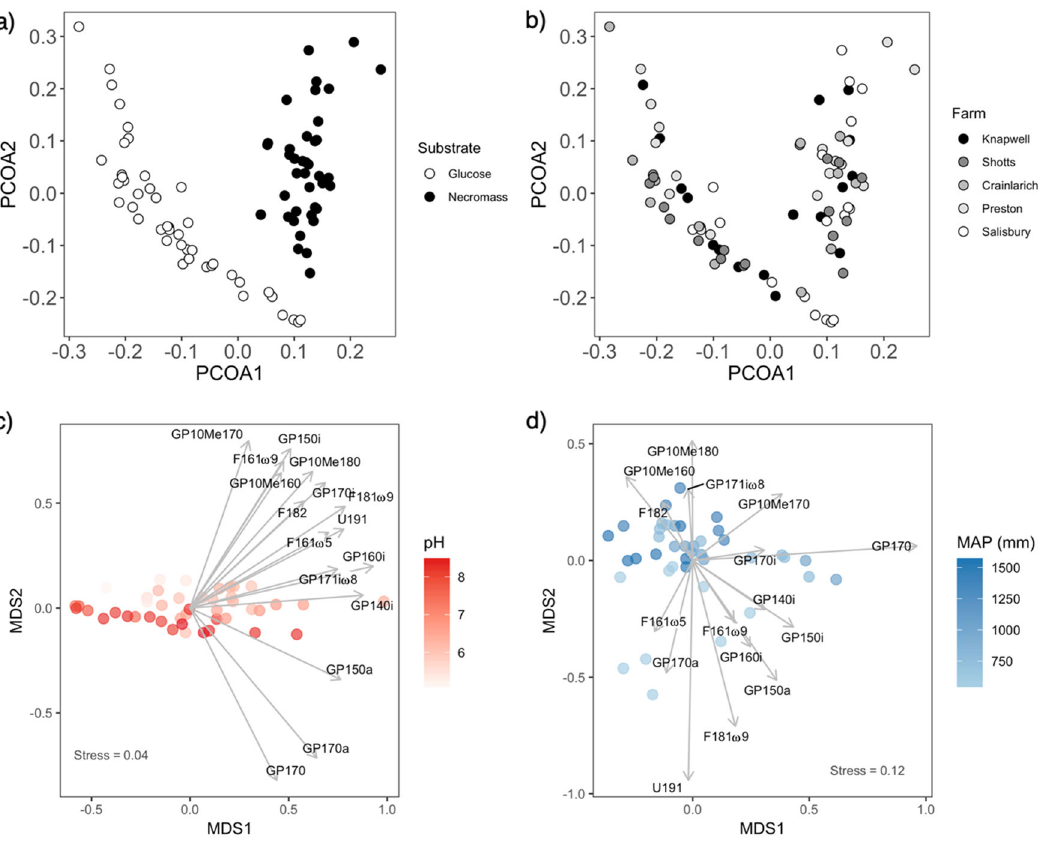
Fig. 5 Assimilation of necromass and glucose by soil microbial communities, identi fi ed through PLFA-stable isotope probing ( 13 C-incorporation into microbial phospholipids). Microbial substrate use is substrate-speci fi c, not site-speci fi c, as indicated by the clear division by substrate type ( a ), with no